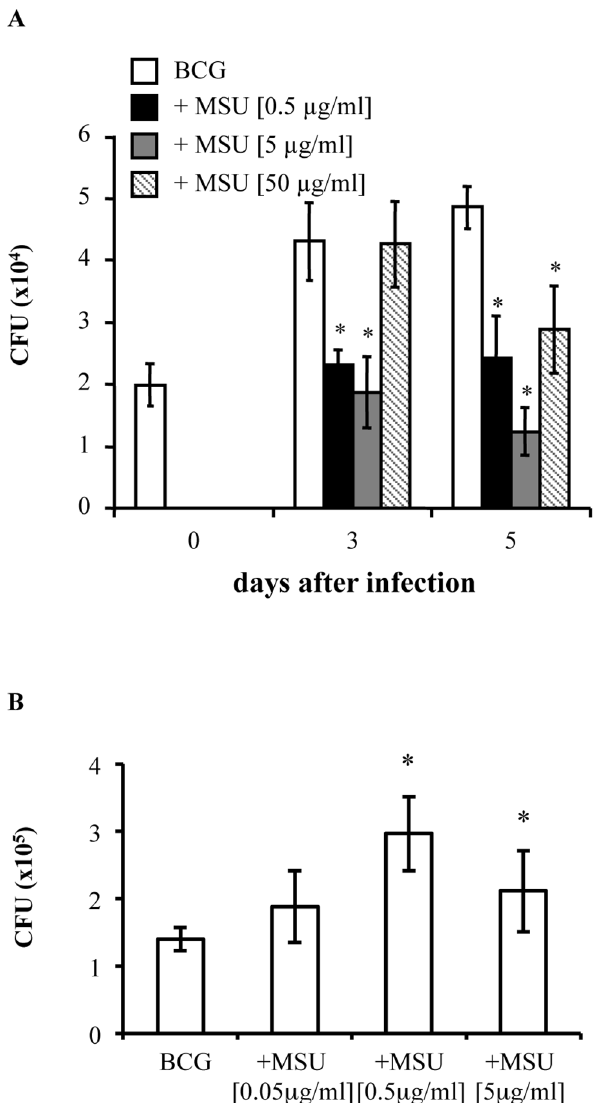
Fig 1. MSU crystals enhance antimycobacterial activity. ( A ) Differentiated THP-1 (dTHP1) cells were infected with BCG at the MOI of 1 and then stimulated or not with 0.5, 5, 50 μ g/ml of MSU for 3 and 5 days. The results are expressed as means ± Standard Deviation (SD) of CFU values performed in triplicate and are representative of three independent experiments. * p (cid:3) 0.001 in comparison with non-stimulated control cells. ( B ) Stimulation of human macrophages with MSU enhances phagocytosis of BCG. Differentiated THP- 1 cells were exposed to BCG at the MOI of 1 for 3 hour in the presence or not of 0.05, 0.5, 5 μ g/ml MSU. Results are expressed as mean ± SD of CFU values performed in triplicate and are representative of two independent experiments. * p < 0.05 in comparison with non-stimulated control